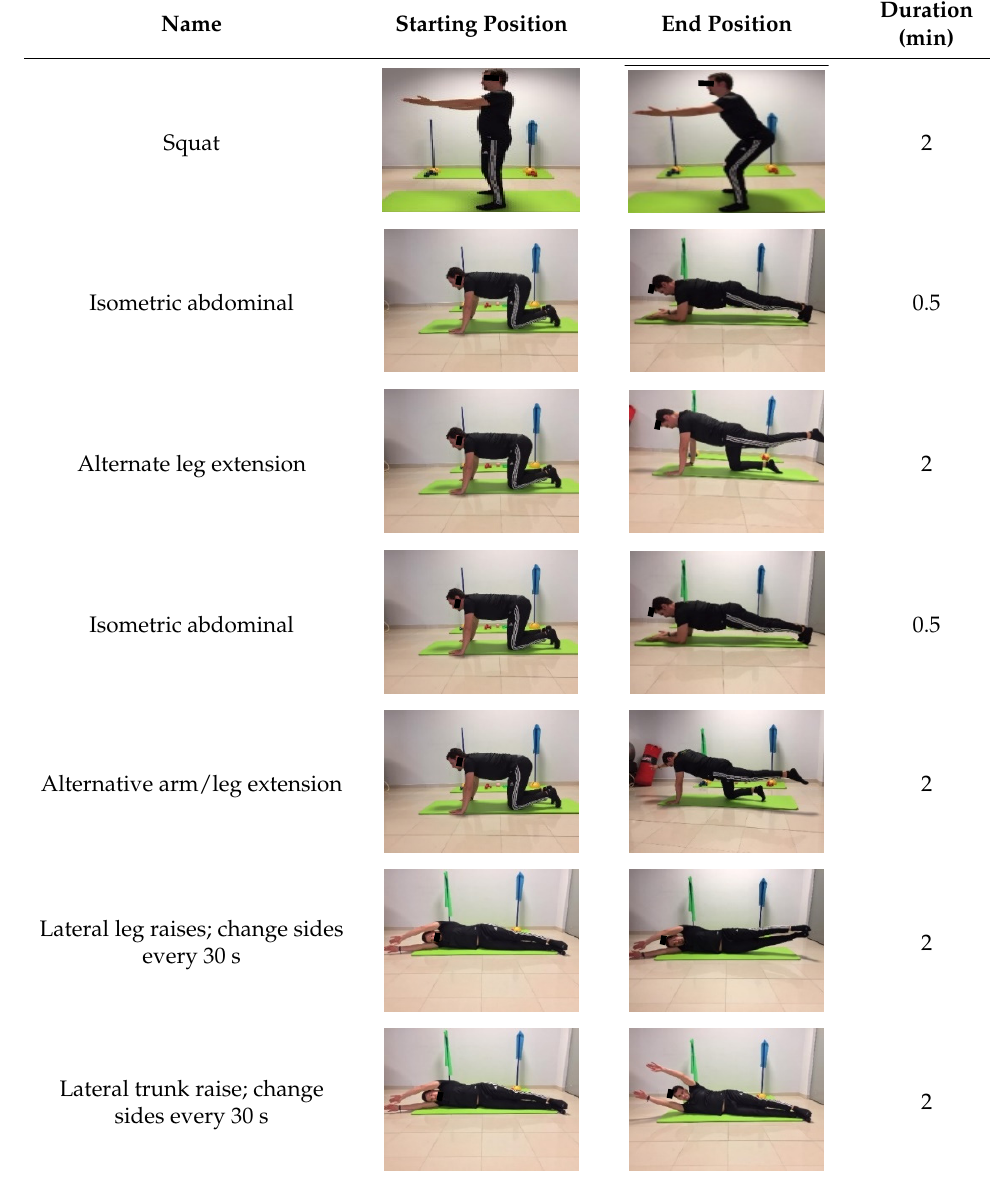
Table 2. Overview of the exercises in the main part.